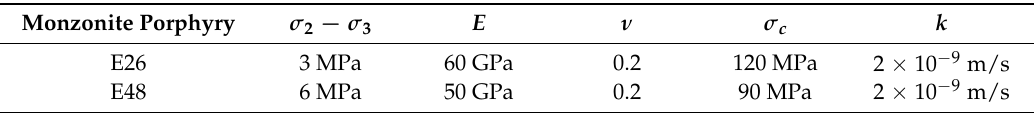
Table 10. Differential stress magnitudes and rock properties in the E26 and E48 orebodies at Northparkes Mine [34,35].